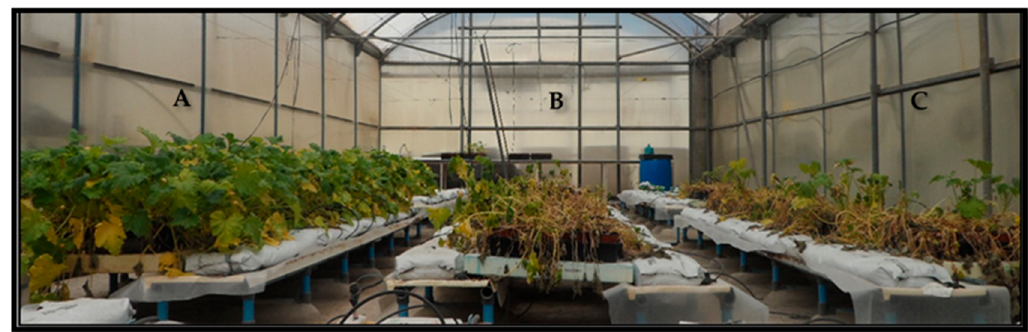
Figure 6. Disease severity of phytopathogens in plants was rated 30–90 d after inoculation based on a 0–5 scale: where 0 = no visible disease symptoms and 5 = plant dead. T0: control; TAET1: T. aggressivum f. europaeum TAET1; Bot: B. cinerea ; Mym: M. melonis ; Scle: S. sclerotiorum ; Rz : R. solani ; FSC: F. solani f . cucurbitae ; Pya: P. aphanidermatum . Mean standard deviation is expressed by error bars (24 plants per repetition). Means with the same letter are not significantly different (LSD) according to the ANOVA ( p < 0.05).